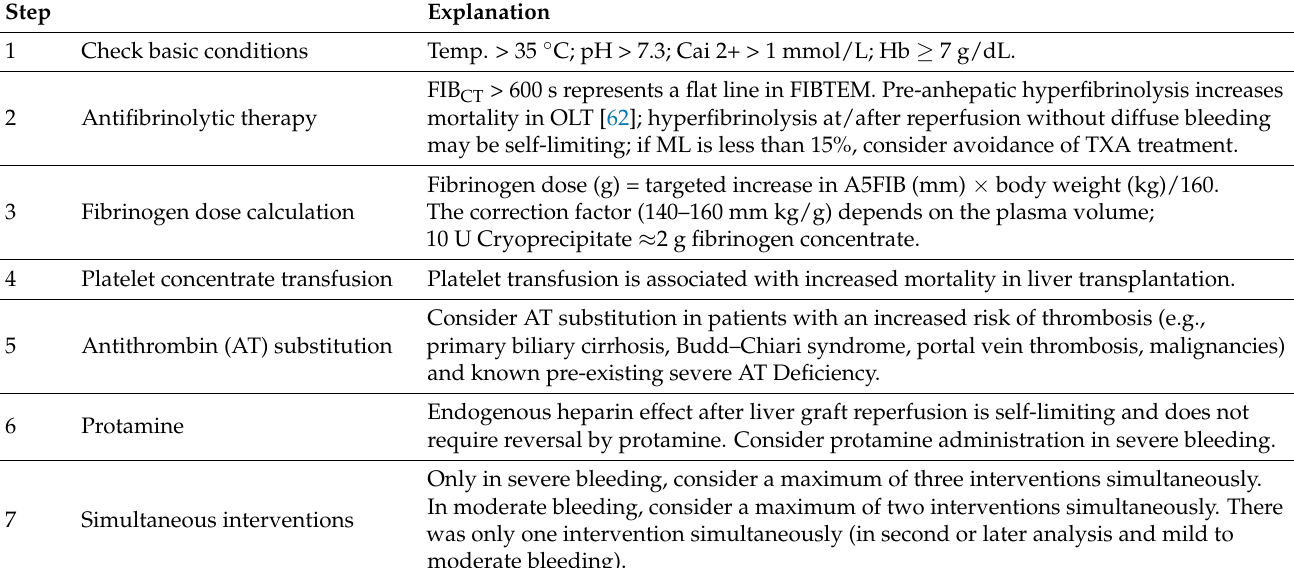
Table 2. Evidence-based algorithms for ROTEM (A5)-guided bleeding management in adult liver transplantation.